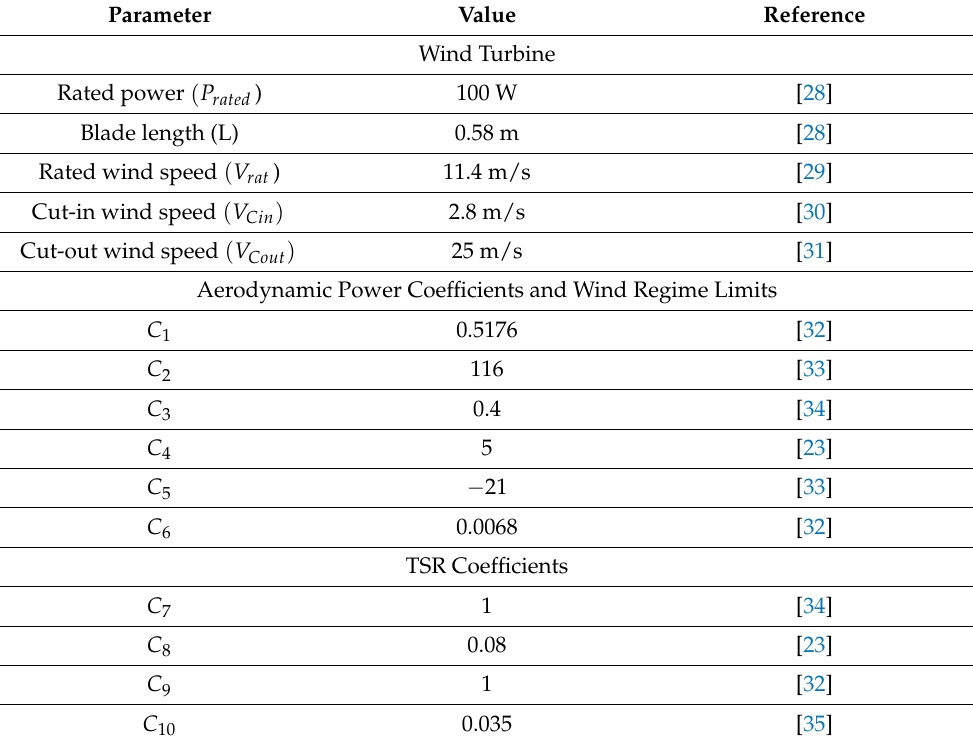
Table 1. Input data used in the optimization